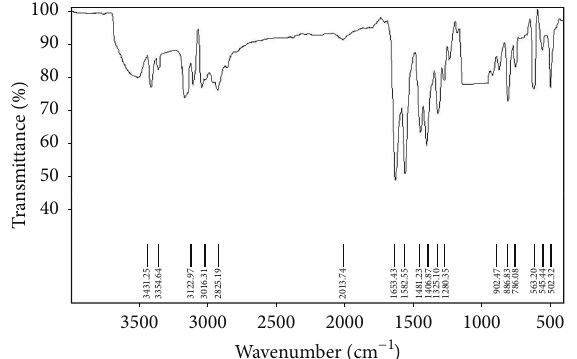
Figure 1: IR spectrum of zinc-diosmin complex.